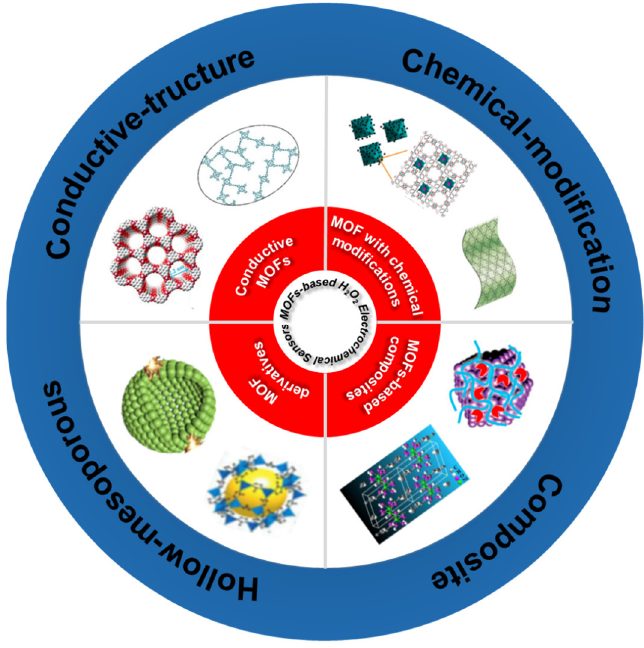
Figure 1. Conductive MOFs based H 2 O 2 sensors; chemically modified MOFs-based H 2 O 2 sensors; MOFs composites based H 2 O 2 sensor; MOF derivatives based H 2 O 2 sensor.